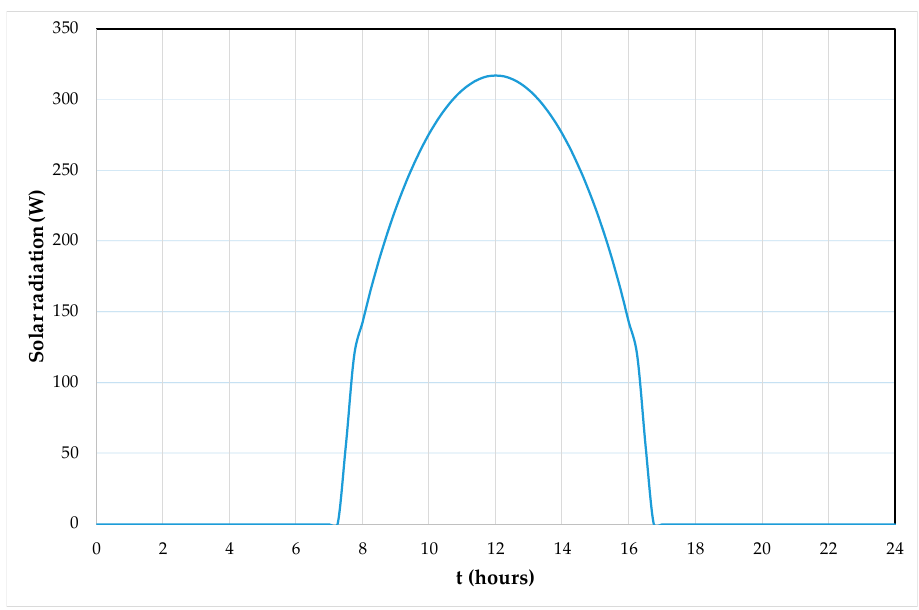
Figure 12. Evaluation of transmitted solar radiation of the glazed surface of a DSF module. In Figures 13–22, the evolution of the air temperature of the outdoor environment, the indoor virtual chamber and the indoor DSF system are presented.